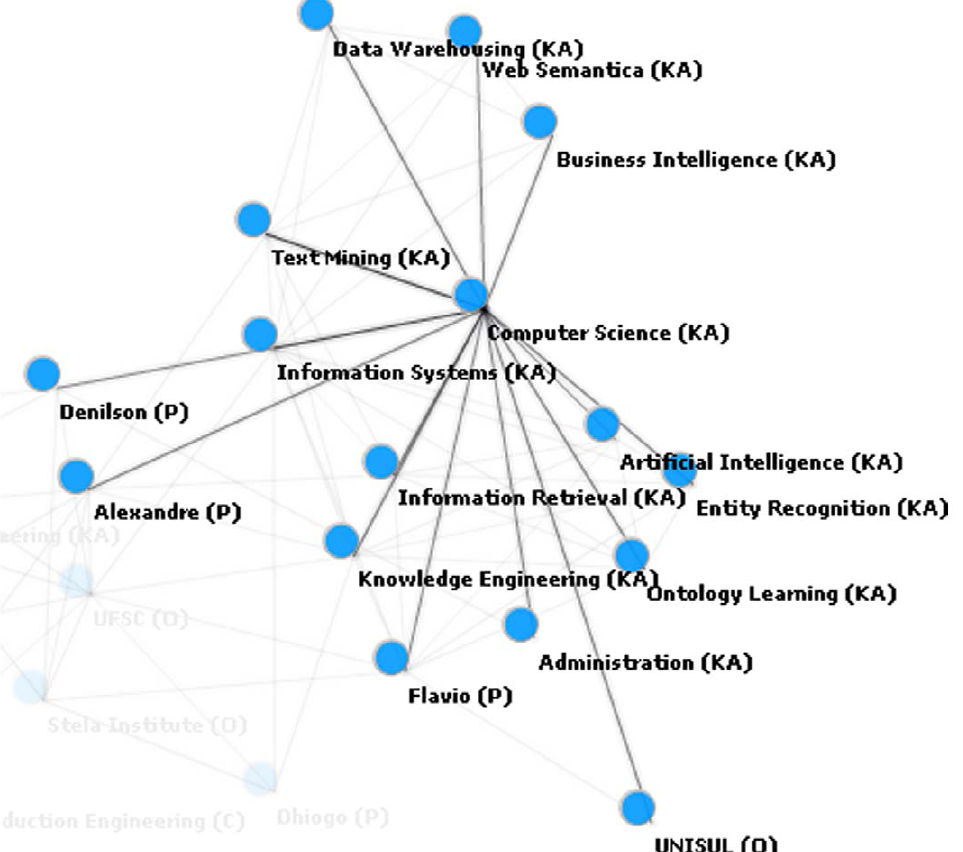
Figure 3. Specific network graphic for the computer science instance.